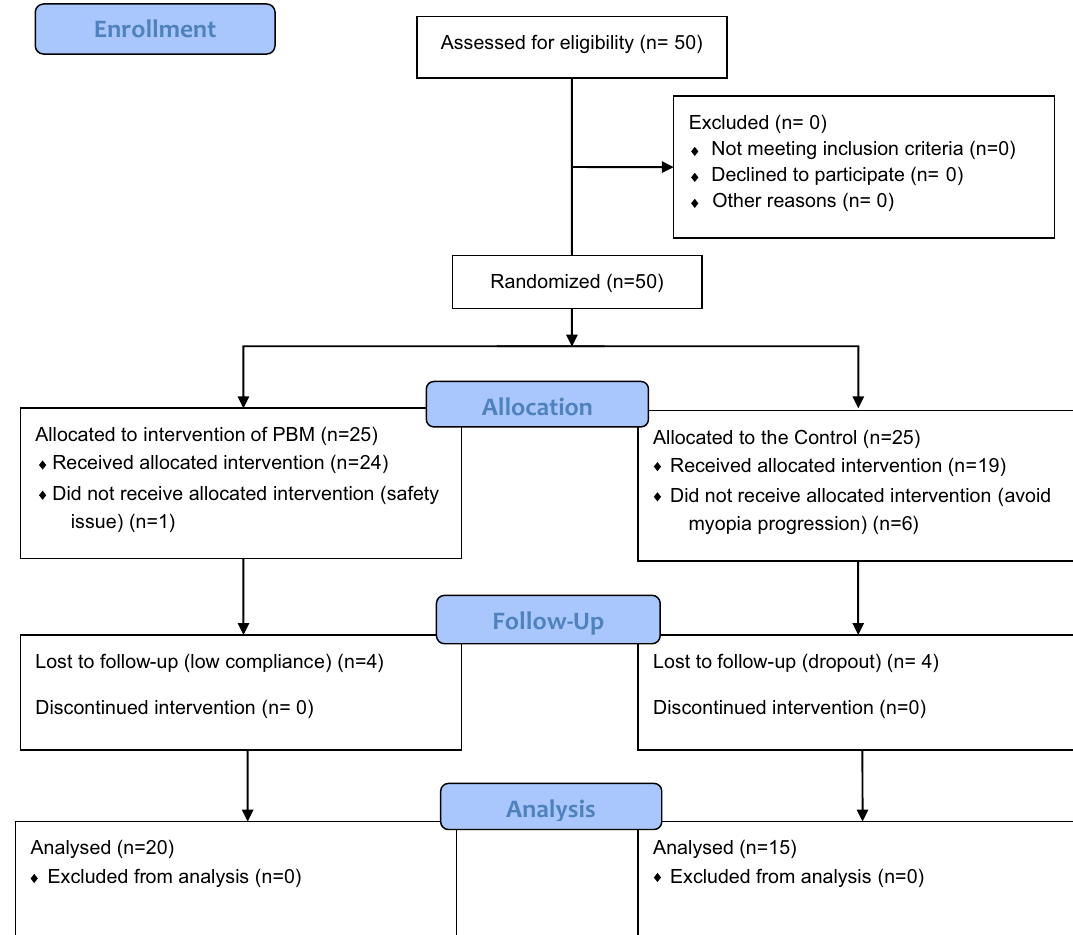
Figure 1. Flow diagram. PBM photobiomodulation therapy, Control single vision spectacles only.